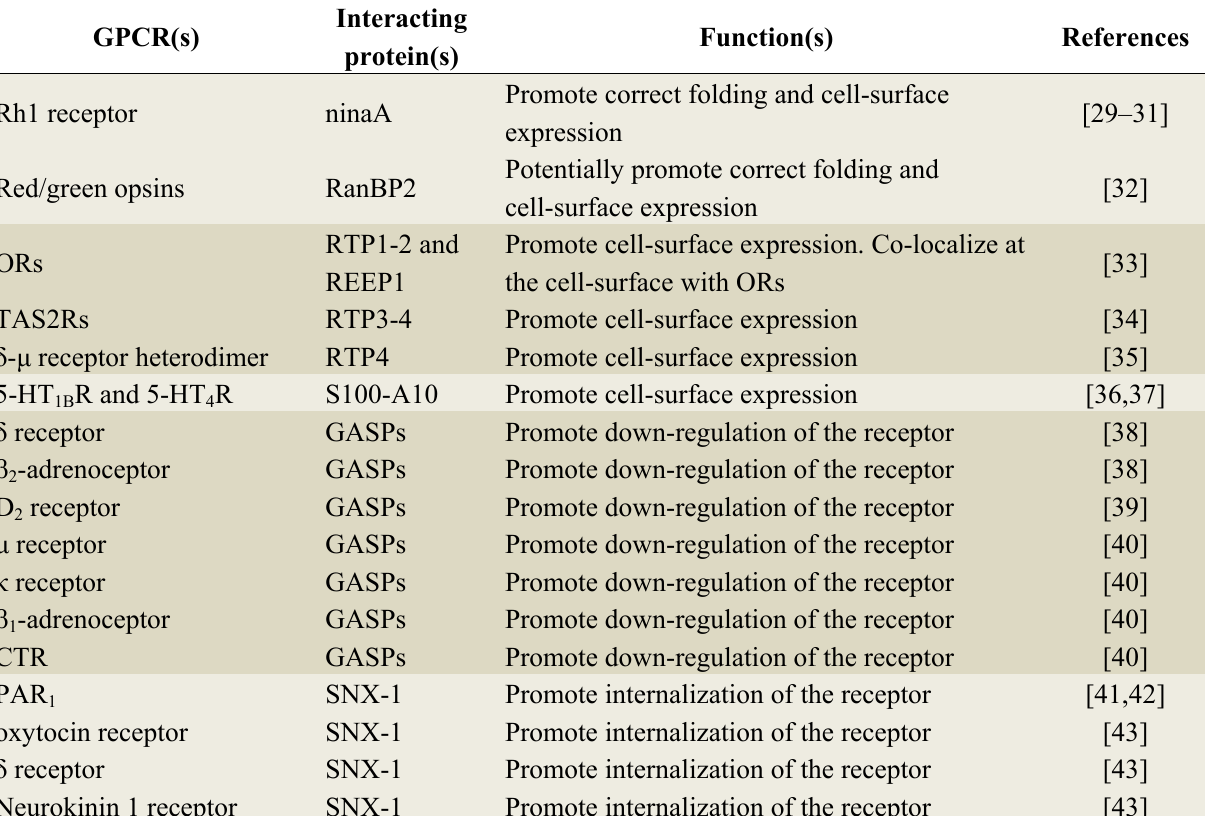
Table 1. Interacting proteins that influence cell-surface localization of G protein-coupled receptors